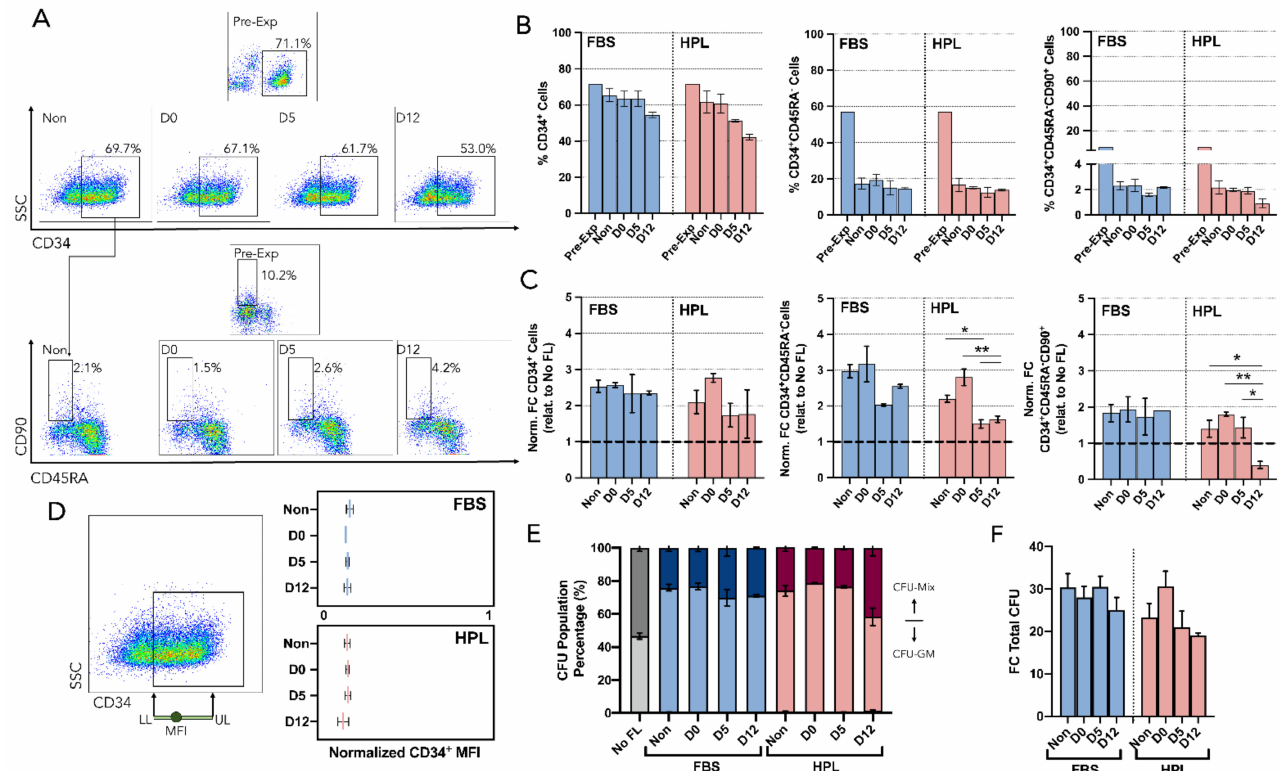
Figure 6. Immunophenotype and clonogenic potential (CFU) of hematopoietic stem/progenitor cells co-cultured with MSC(AT). ( A ) Representative dotplots showing the gating strategy used for the identification of different HSPC populations before expansion (Pre-Exp) and after expansion using released (D0, D5, and D12) or non-encapsulated (Non) MSC(AT) as feeder layers. Live HSPC were gated on forward scatter (FSC) versus side scatter (SSC) followed by the use of a viability dye. Then, CD34 expression was identified ( top ) and CD45RA and CD90 expression were also investigated to explore the remaining populations ( bottom ). ( B ) FC of normalized CD34 + (relative to the control No FL) ( left ), CD34 + CD45RA − ( center ), and CD34 + CD45RA − CD90 + ( right ). ( C ) Percentage of CD34 expression ( left ), CD34 + CD45RA − ( center ), and CD34 + CD45RA − CD90 + ( right ). ( D ) Quantification of CD34 loss after expansion. Mean fluorescence intensity (MFI) of CD34 + expression was quantified and normalized using the width of the positive CD34 population. ( E ) CFU population percentage. Neglectable burst-forming unit-erythroid (BFU-E) led mainly to two populations, including colony forming-unit granulocyte (CFU-GM) and colony forming-unit multilineage (CFU-Mix). ( F ) FC in total CFU number after HSPC expansion using FL from encapsulated and non-encapsulated MSC(AT) which were previously expanded in FBS or HPL supplemented medium. No FL—control condition without an MSC(AT) feeder layer; Non—non-encapsulated; SSC—Side scatter; LL—Lower limit; UL—Upper limit; three MSC(AT) donors; mean ± SEM, * p < 0.05, ** p <